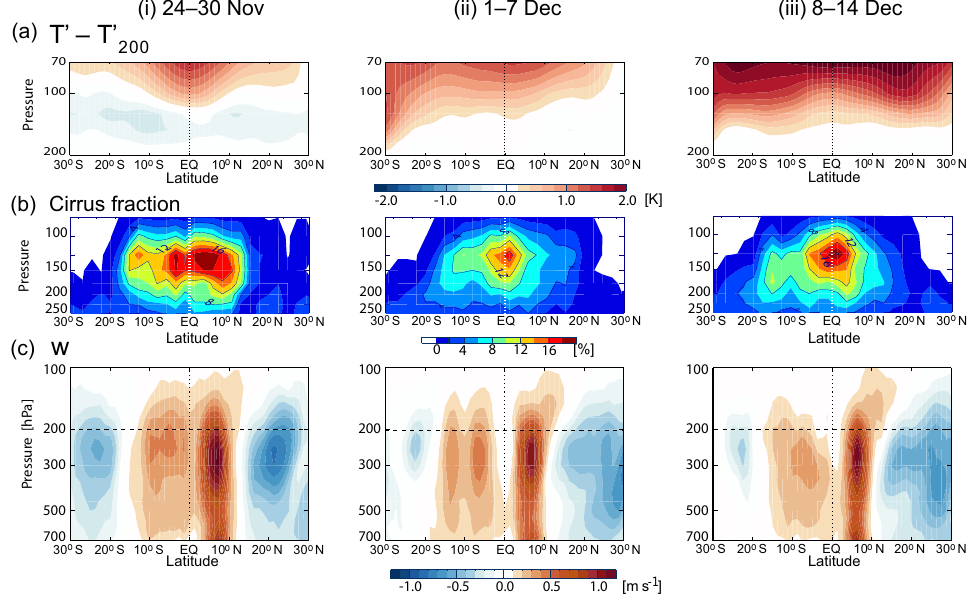
Figure 7. Consecutive 7-day-mean height–latitude sections: (i) 24–30 November, (ii) 1–7 December, and (iii) 8–14 December. (a) Anomalous temperature difference between each pressure level and 200hPa. (b) Cirrus cloud frequency and (c) vertical velocity.